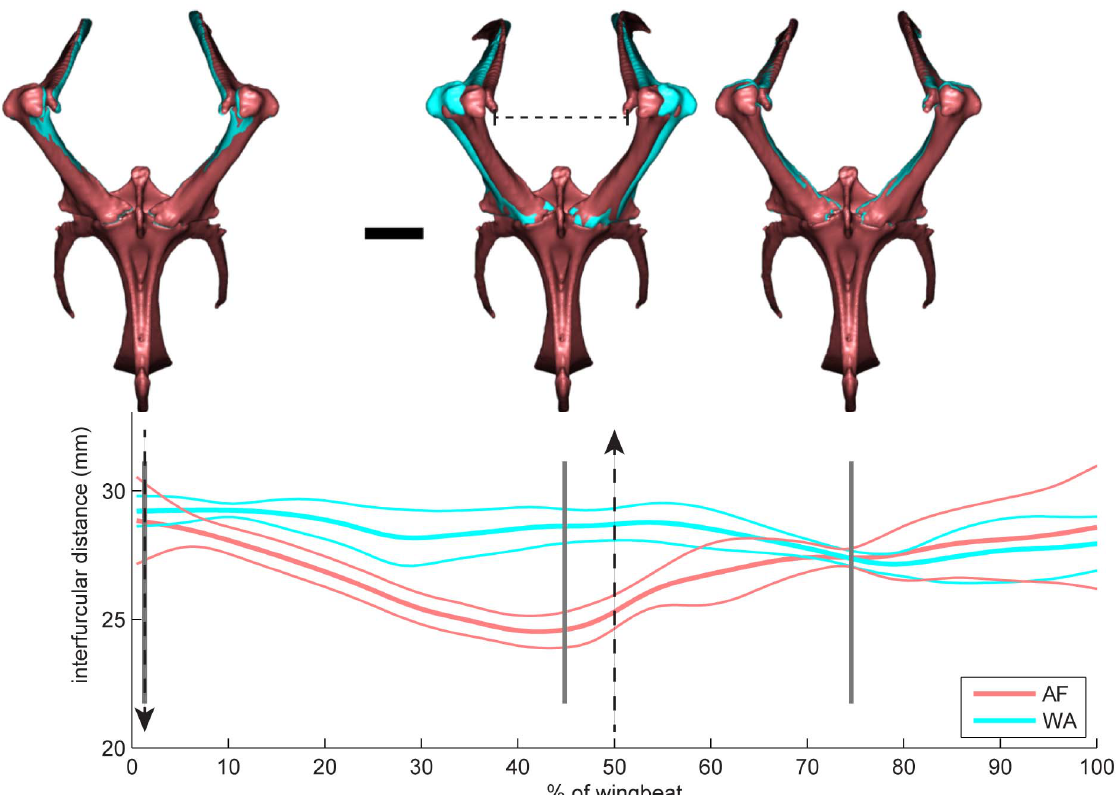
Figure 5. Furcular deformation. Interfurcular distance change comparing AF (red) and WAIR (blue) wingbeats. During both behaviors, the interfurcular distance expands to 129% of resting length near the upstroke/downstroke transition. During WAIR the interfurcular distance remains relatively unchanged, but during AF the coracoids adduct towards the resting configuration during downstroke and then re-expand during upstroke. Dashed vertical lines indicate beginning of downstroke (downward arrow) and beginning of upstroke (upward arrow). Gray vertical lines indicate frames of video imaged above (1, 44, 74). Horizontal dashed bar in middle image is resting length. Scale bar=10 mm.